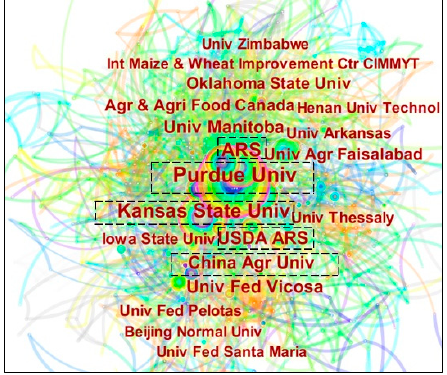
Figure 5. Institutional cooperation network map.